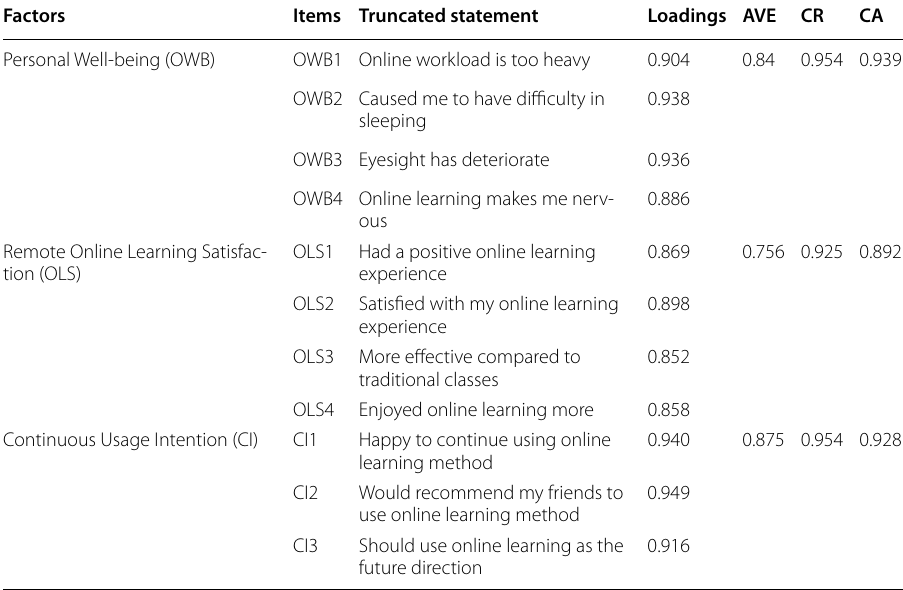
Table 4 Fornell–Larcker criterion analysis